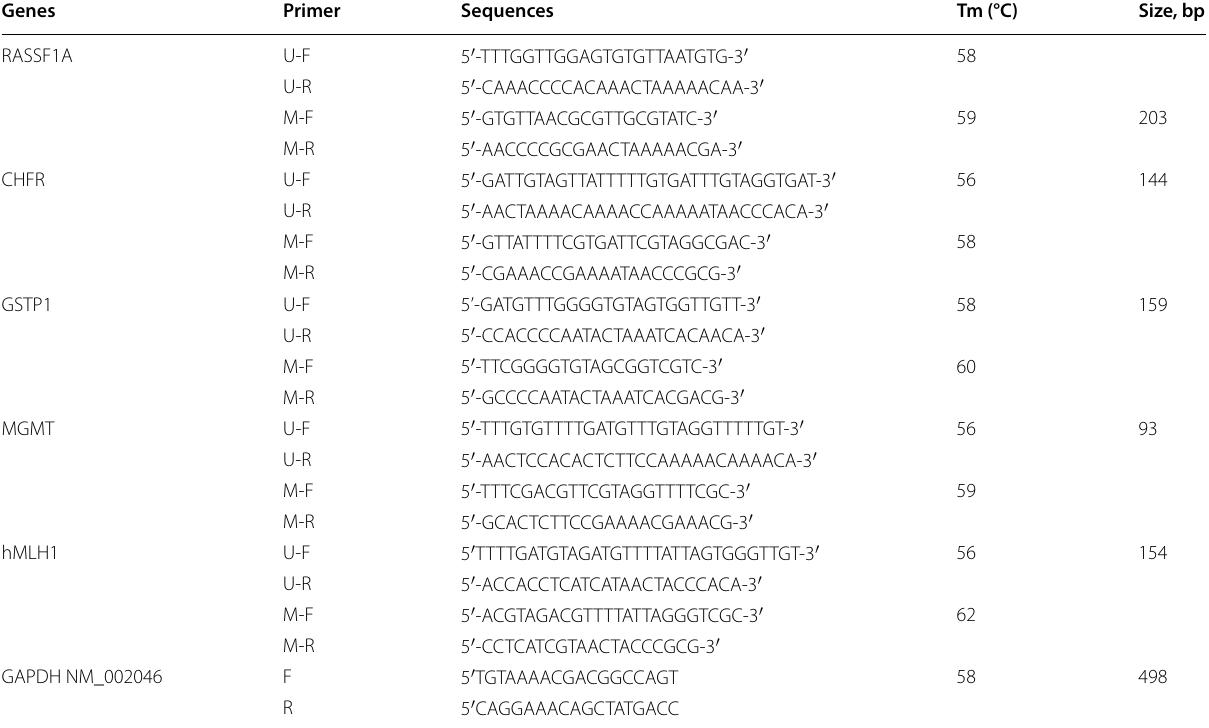
Table 1 Primer sequences, annealing temperatures and amplicon’s bp size used in MSP